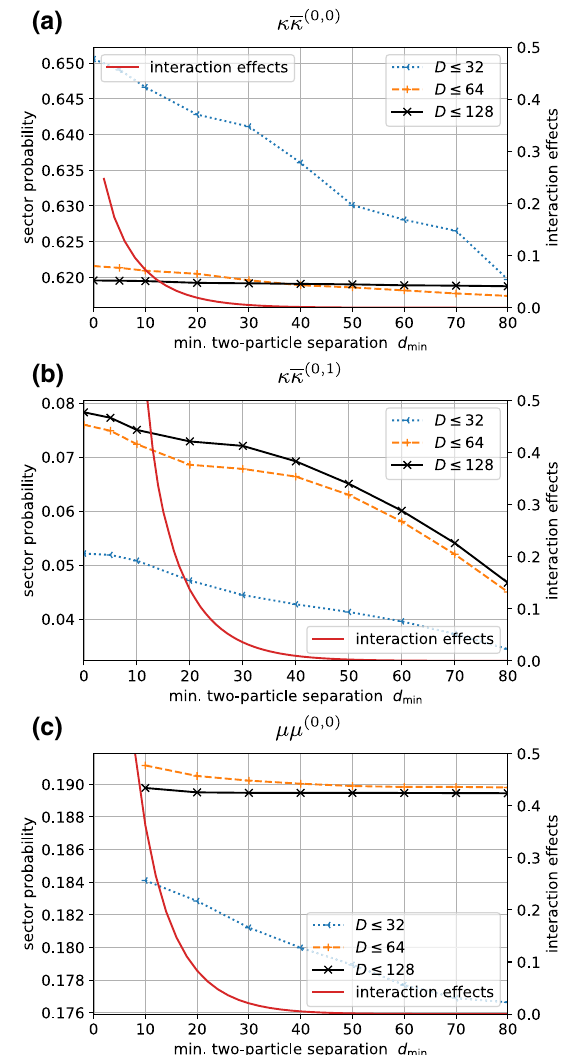
FIG. 19. Quasiparticle “sector” projection probabilities for simulation (ii) of Fig. 7 ( λ = 0.41, g = 0.98, h = 0.001) at time t ≈ 426, as a function of the minimum separation d min : = min ( k − j ) permitted in the two-quasiparticle basis states | · · j , k (cid:3)